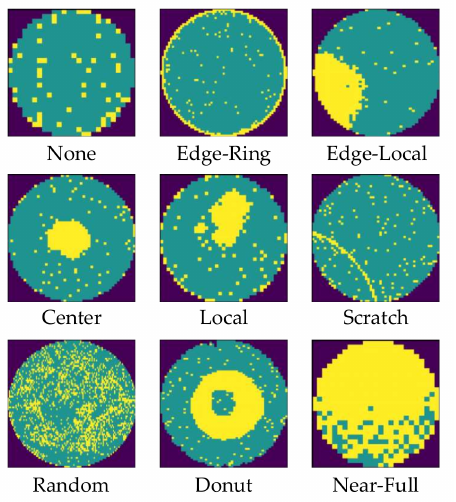
Figure 1. Typical wafer map defect patterns in the WM-811K